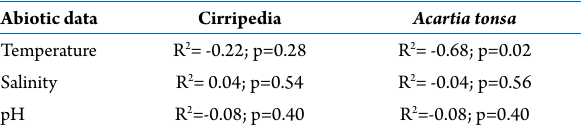
Table 3. Correlations of temporal variations between abiotic data, Cirripedia and Acartia tonsa .